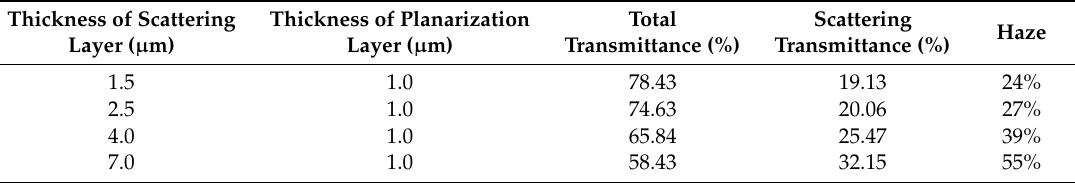
Table 2. Transmittance and haze of the YSZ nanoparticle scattering layer.